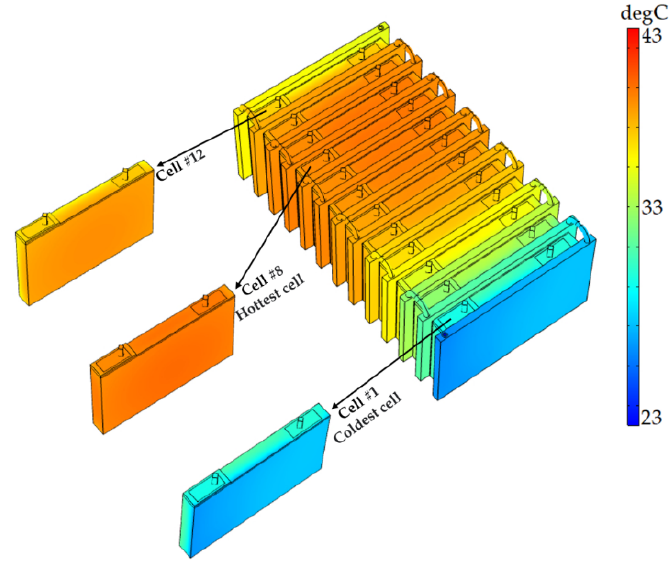
Figure 6. Temperature distribution of the liquid based TMS for LiCs [28].